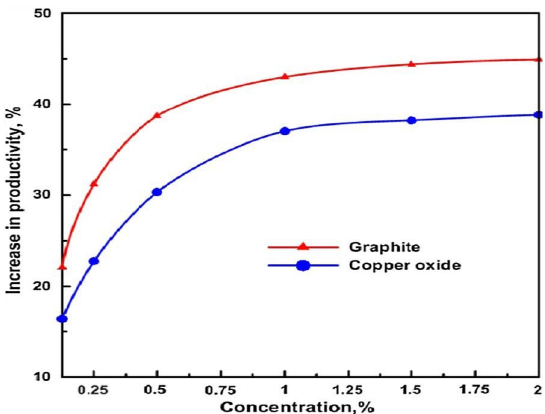
Figure 5. Increment in solar stills productivity with varying nanofluid concentrations [25].